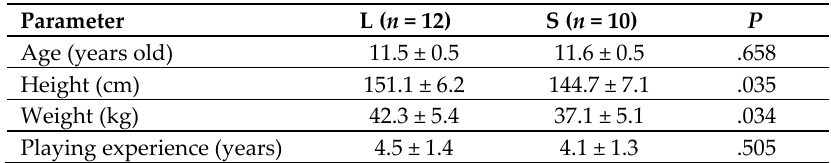
Table 1. Subjects’ profiles.